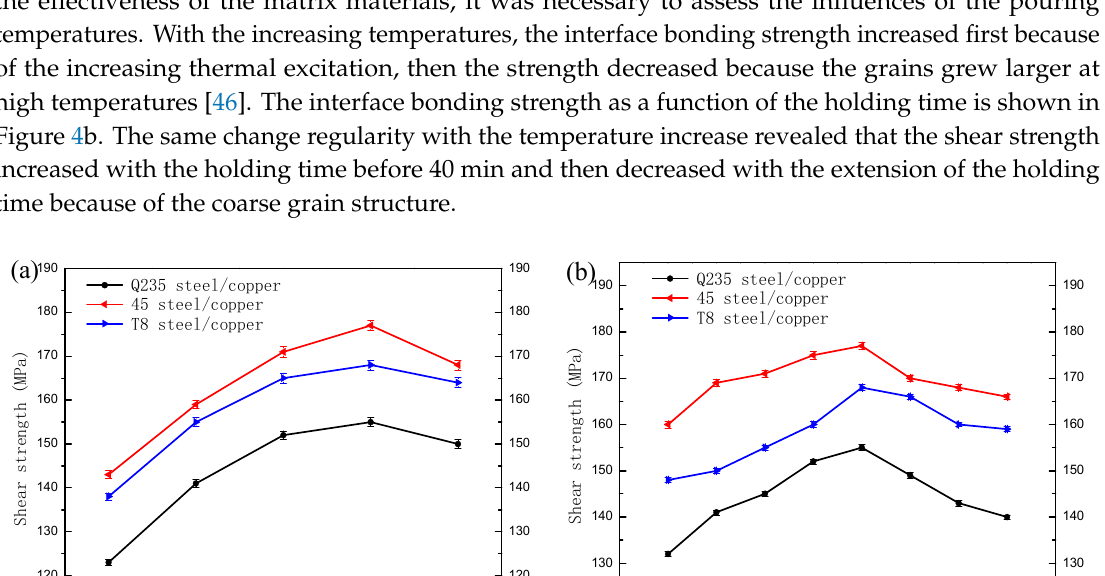
Figure 3. Schematic representation of the specimen location and shear equipment: ( a ) location of specimens and ( b ) testing process of the bimetallic shear strength.